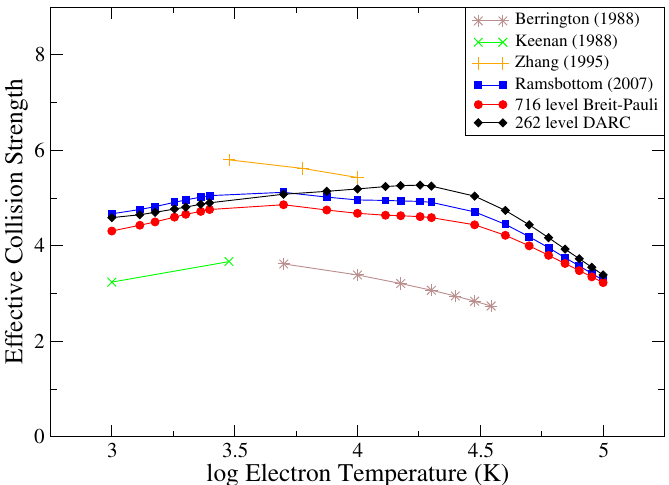
Figure 1. Effective collision strengths for the 3d 6 4s 6 D 7/2 - 3d 6 4s 6 D 5/2 forbidden transition. Red circles and black diamonds are the current Breit–Pauli and DARC results, respectively. Blue squares are the results of [15]; orange pluses are the results of [11]; green crosses are the results of [35]; and brown stars are the results of